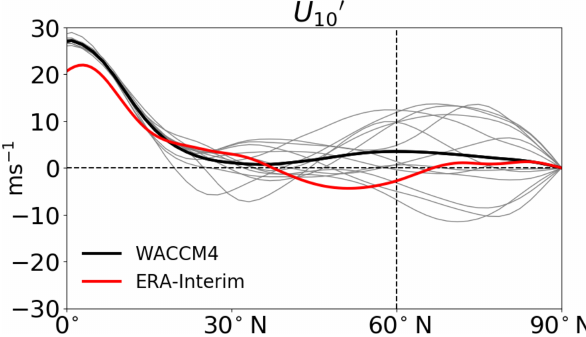
Figure 8. Zonal mean zonal wind anomalies at 10hPa ( U (cid:48) itude, for the individual WACCM4 simulations (gray), for the en- semble mean (black) and for the ERA-Interim reanalysis